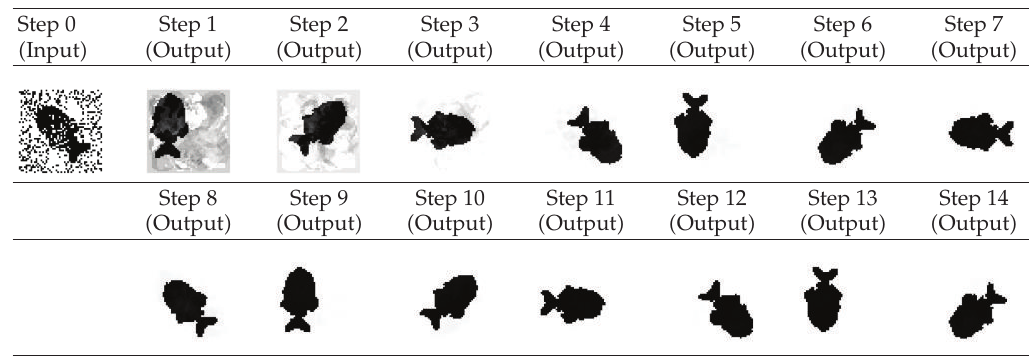
Table 8: Network recall using a noisy input: 700 pixels flipped (cid:3) 28% (cid:4)